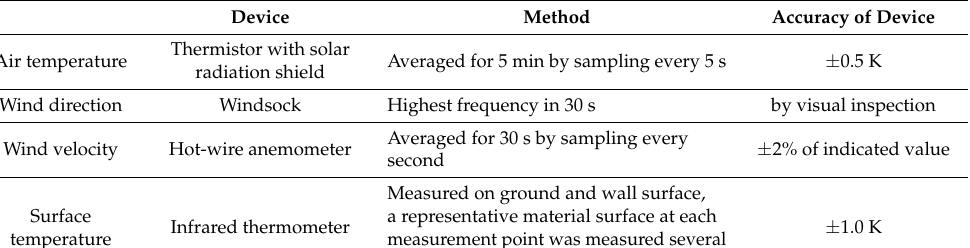
Table 1. Measuring device and method.